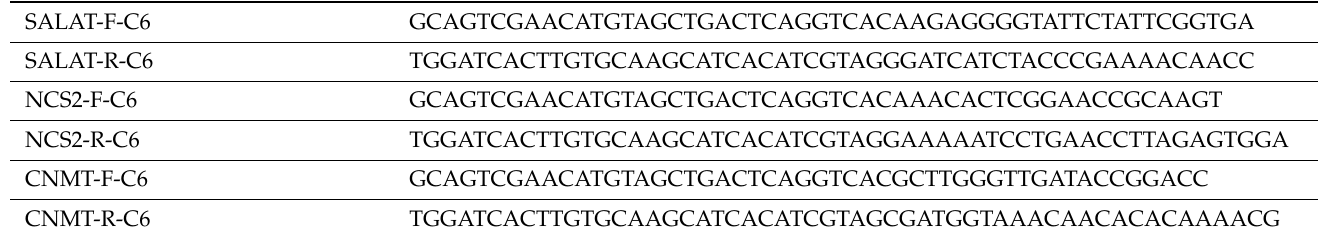
Table 4. Primer sequences for mutation gene screening including barcoding overhangs. Left